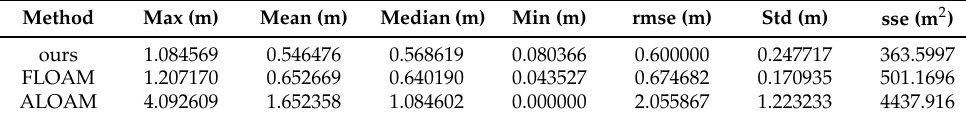
Table 2. The Absolute Pose Error comparison of our method, FLOAM and ALOAM on KITTI07.